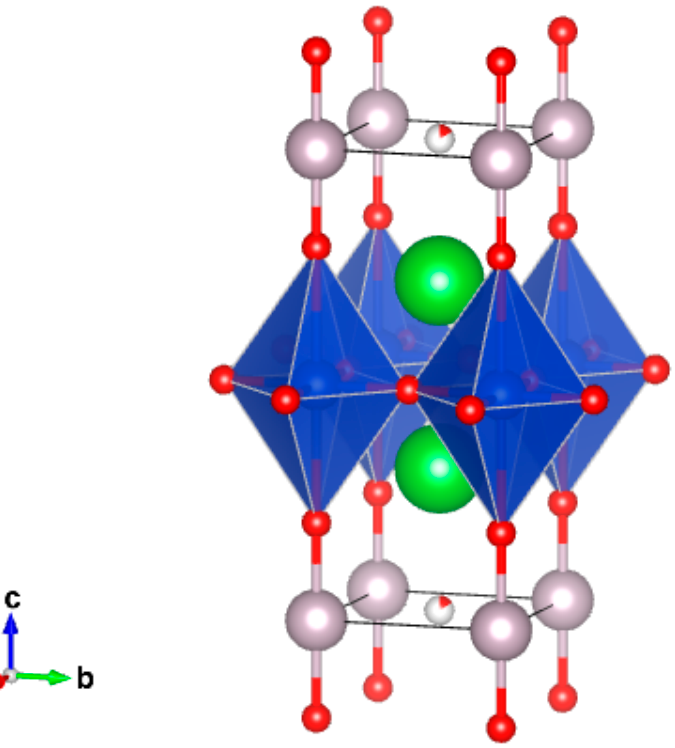
Figure 1. Crystal structure of Hg-1201. The coordination polyhedra of copper (distorted octahedron) and Hg (dumbbell) are shown.